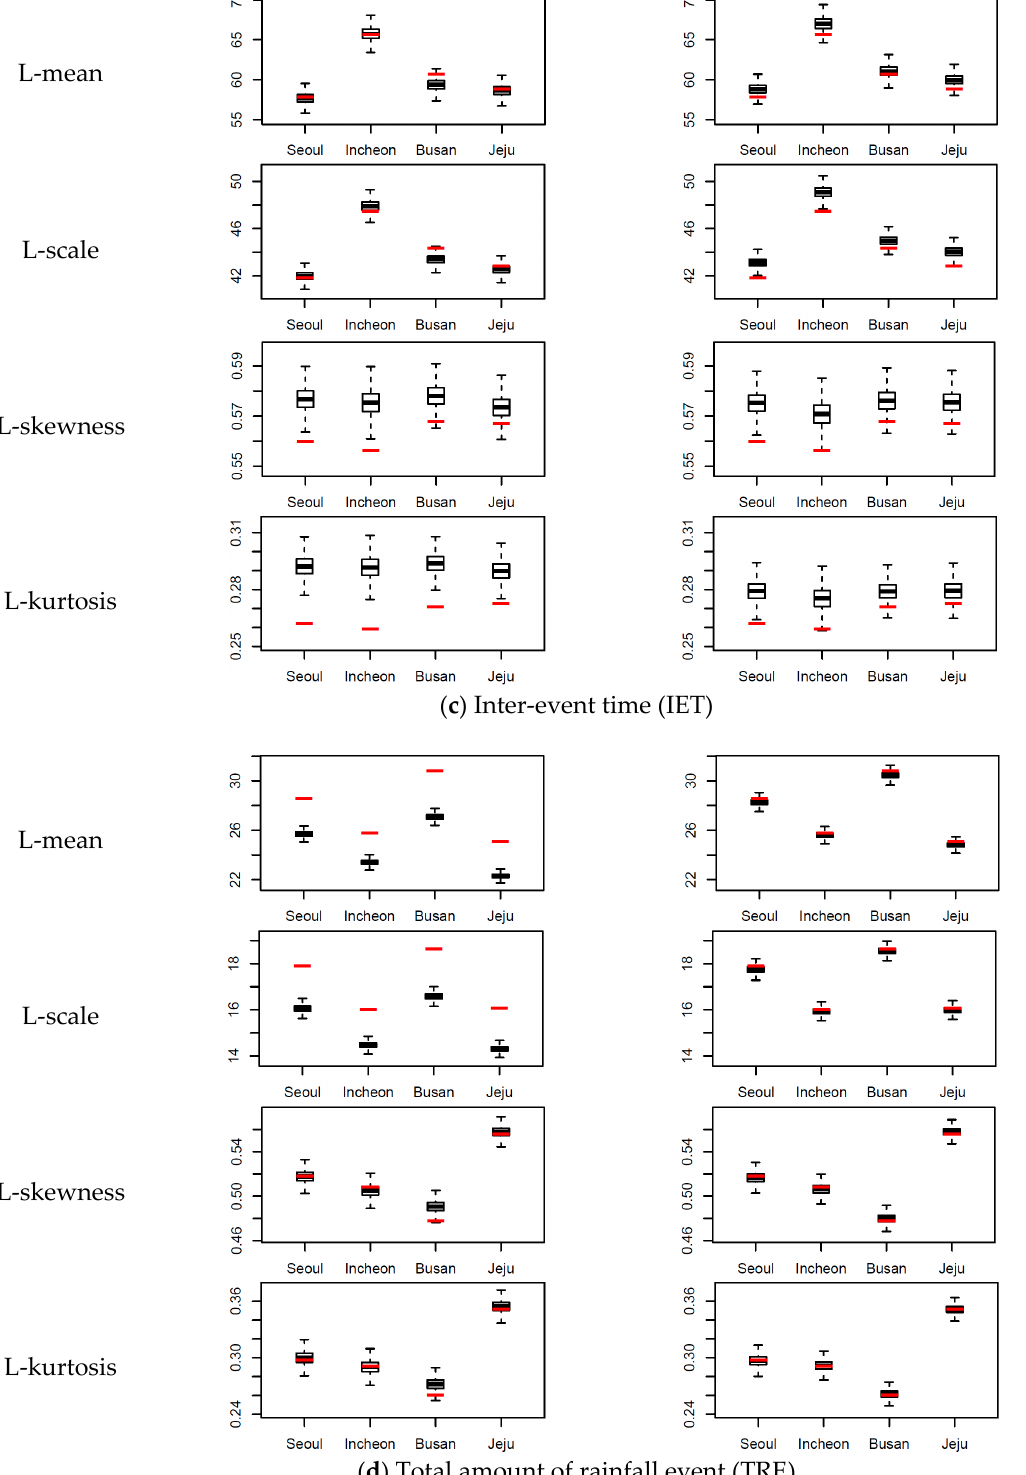
Figure 7. L-moment statistics (L-mean, L-scale, L-skewness, and L-kurtosis) using KNNR method without 3-day rainfall patterns and the proposed KNNR method with 3-day rainfall patterns. Red lines in graph indicates L-moment statistics of original hourly data. ( a ) hourly rainfall depth, ( b ) event duration, ( c ) inter-event time, and ( d ) total amount of rainfall event in four observatories.